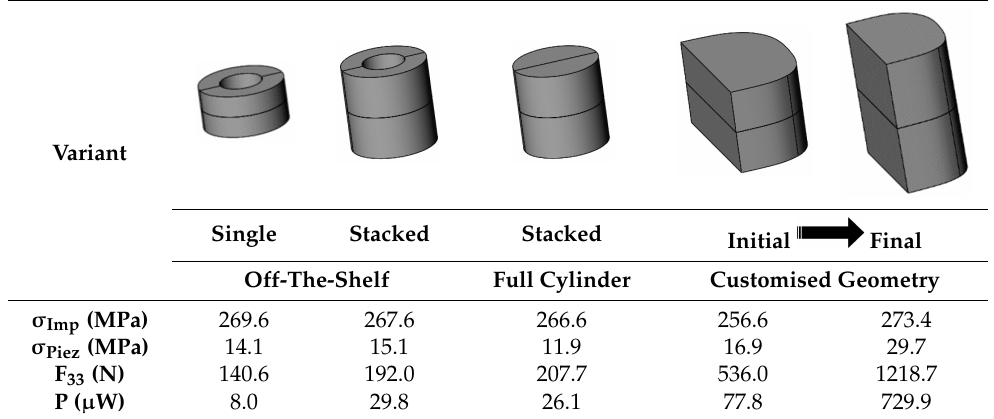
Table 5. Output results of the different geometry variants and the initial and final geometry variants for the iterative design